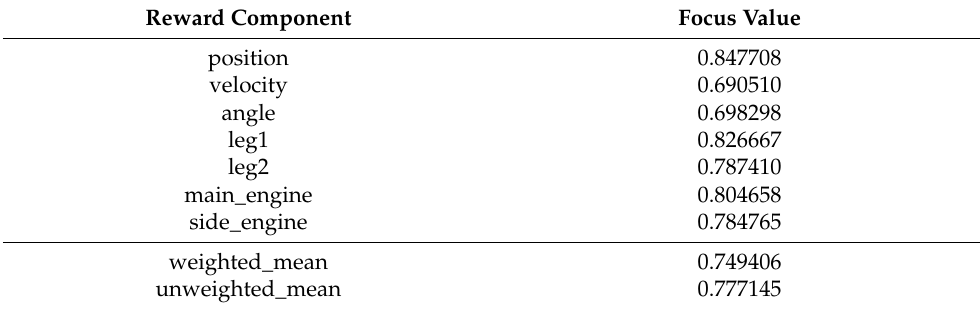
Table A9. Focus value of the Lunarlander